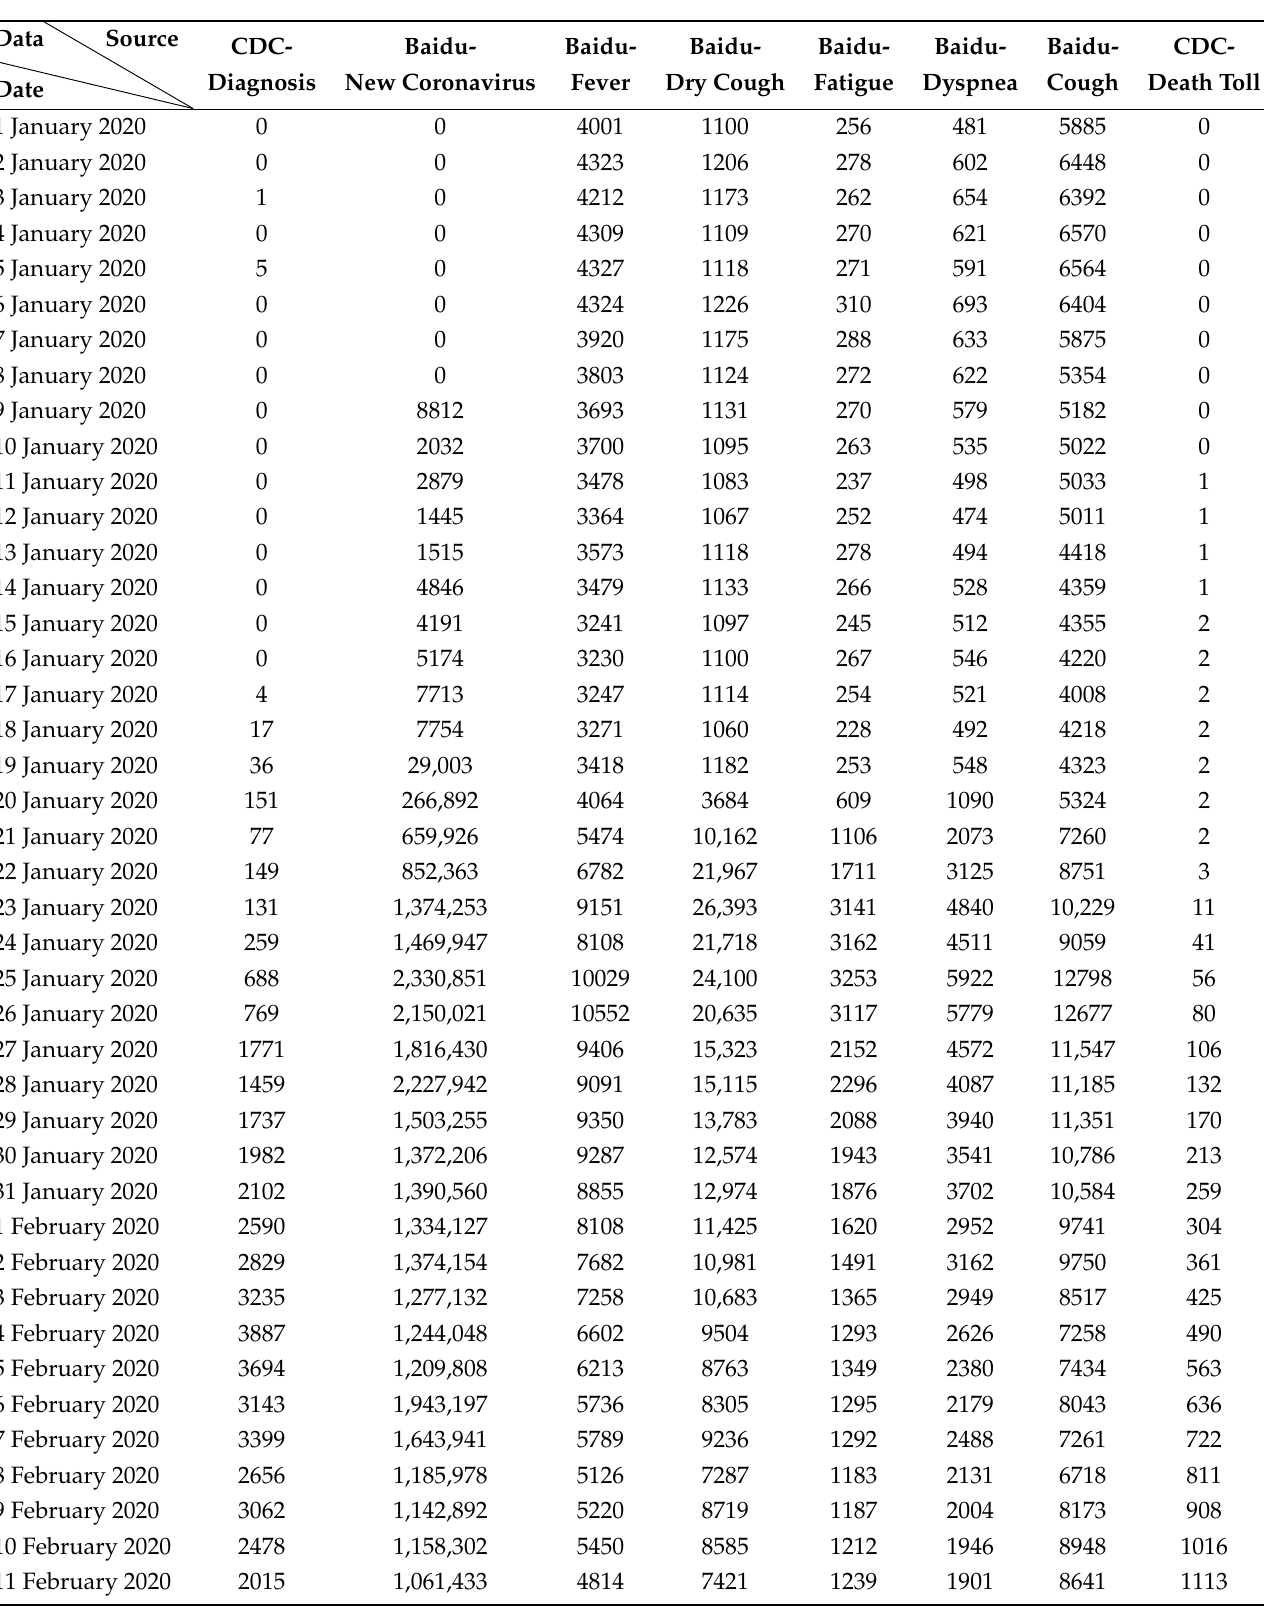
Table A1. Datasets from CDC and Baidu Index